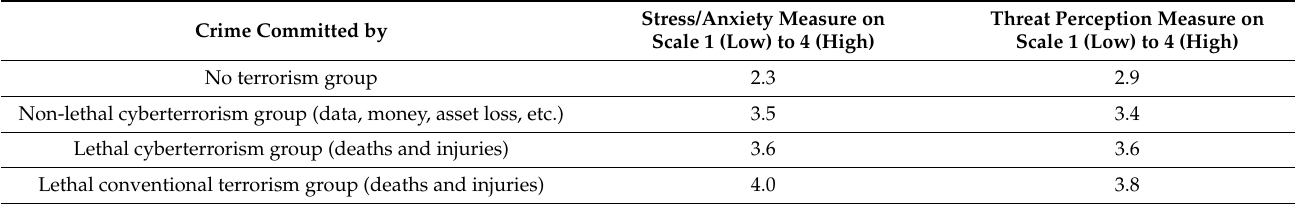
Table 4. Quantifying stress/anxiety and threat levels under cyber attacks in smart